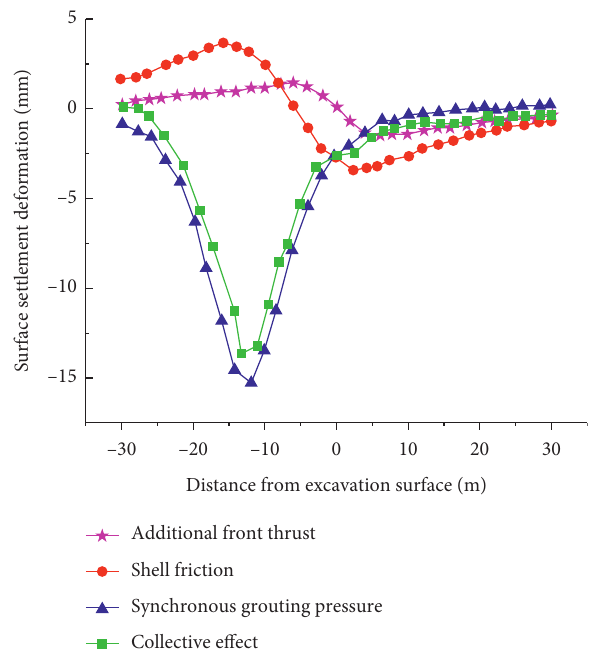
Figure 13: Longitudinal deformation of the ground surface caused by quasi-rectangle shield construction.